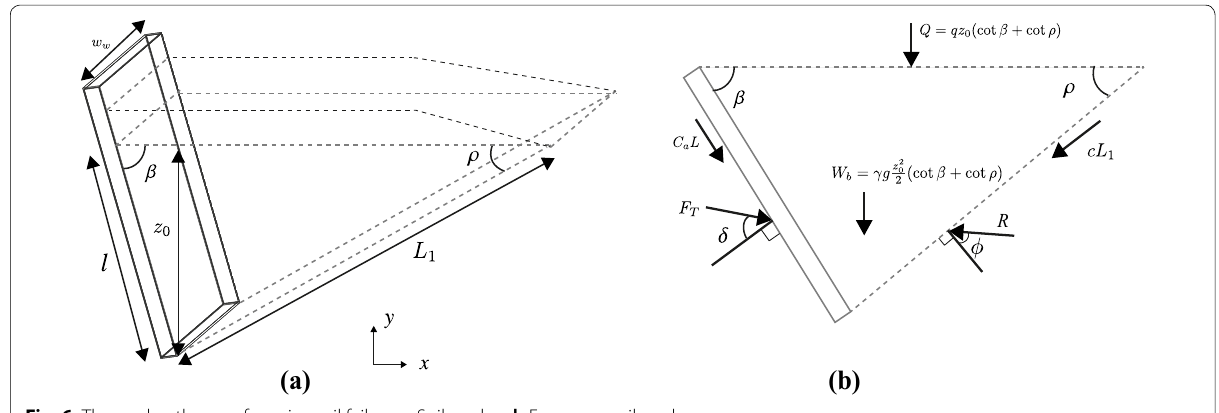
Fig. 6 The wedge theory of passive soil failure. a Soil wedge. b Forces on soil wedge